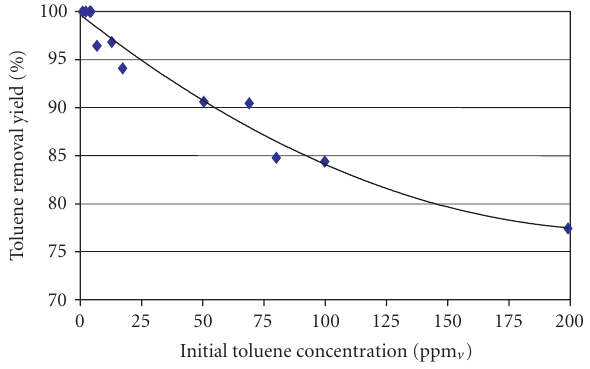
Figure 5: Variation of the toluene removal yield versus the initial toluene